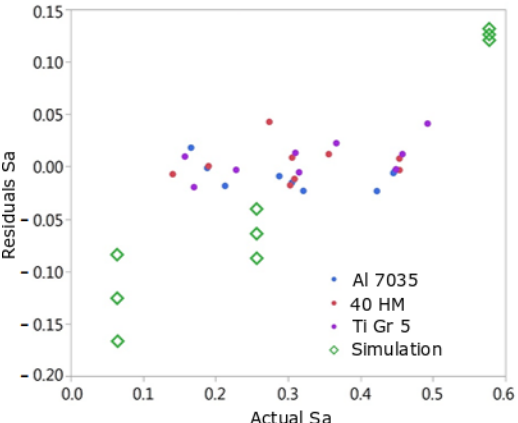
Figure 15. Graph of residuals depending on the real value of Sa for the tests used to build the model (Aluminum, Steel, Titanium) and the surface simulation tests after milling.